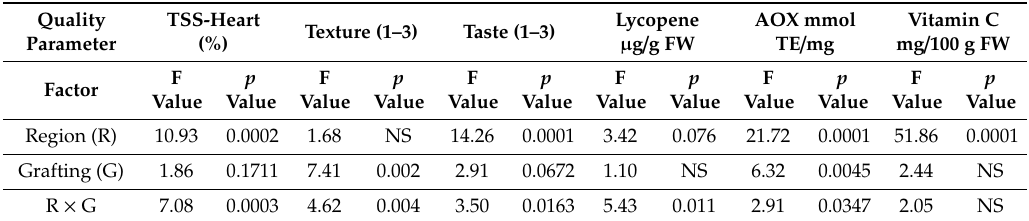
Table 4. A factorial analysis to evaluate the influence of the region, the grafting, and their interaction on fruit quality after 4 days at 21 ◦ C at P = 0.05 ( F and p values). Quality